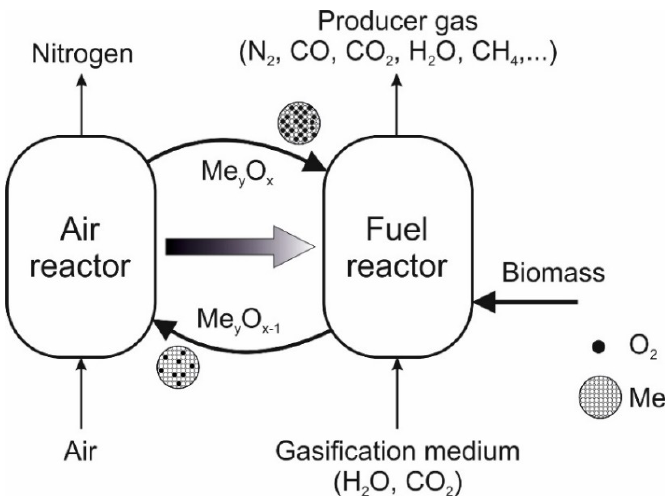
Figure 2 . Schematic flow diagram of the chemical looping gasification process . Figure 2. Schematic flow diagram of the chemical looping gasification process.